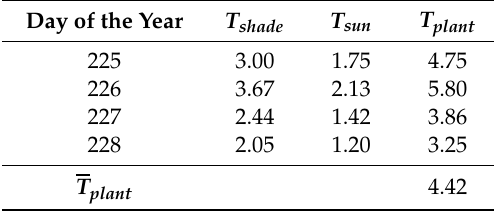
Table 4. Modified Penman–Monteith T plant estimates during the same days that sap flow was measured at the Deciduous site (measured in 2004). T plant is the summation of T shade and T sun . T plant is the average of the daily T plant . All estimates are in mm /